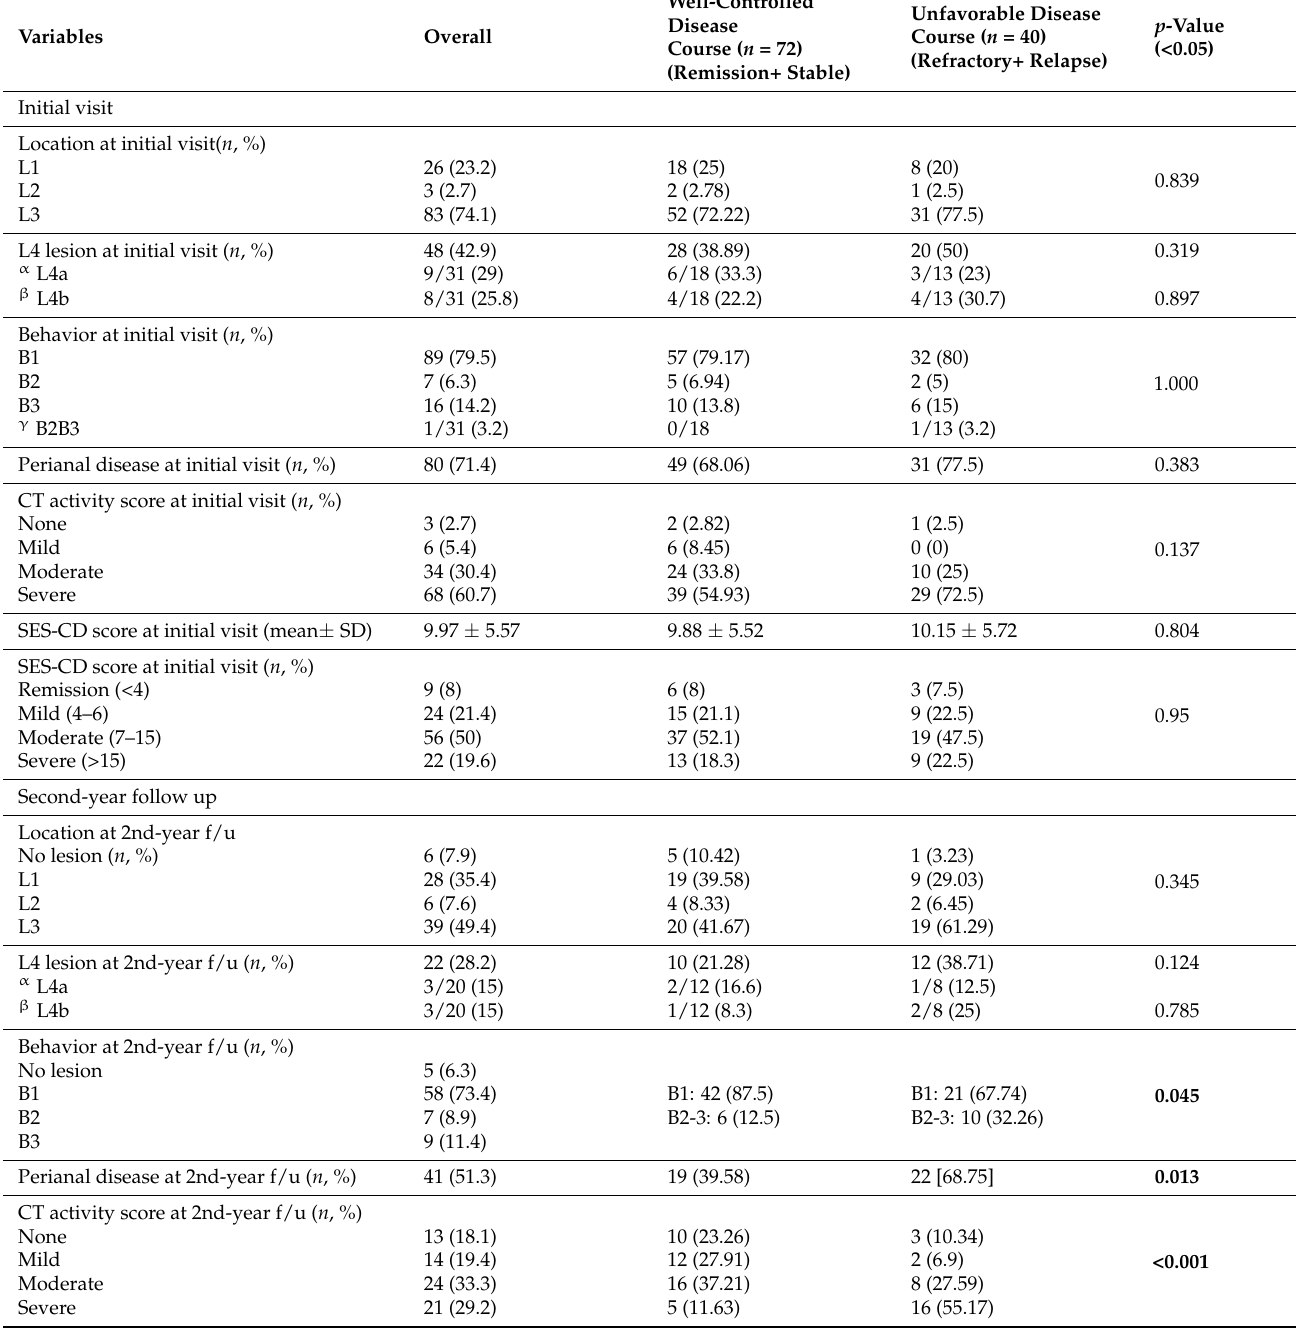
Table 3. Comparison of disease characteristics of CD patients between well-controlled and unfavor- able disease